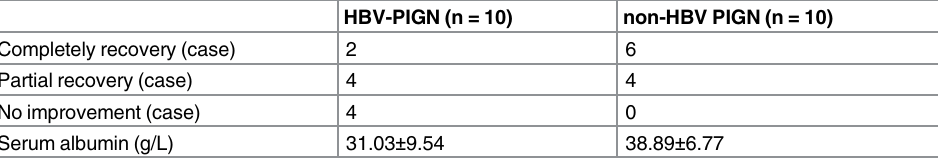
Table 3. Clinical